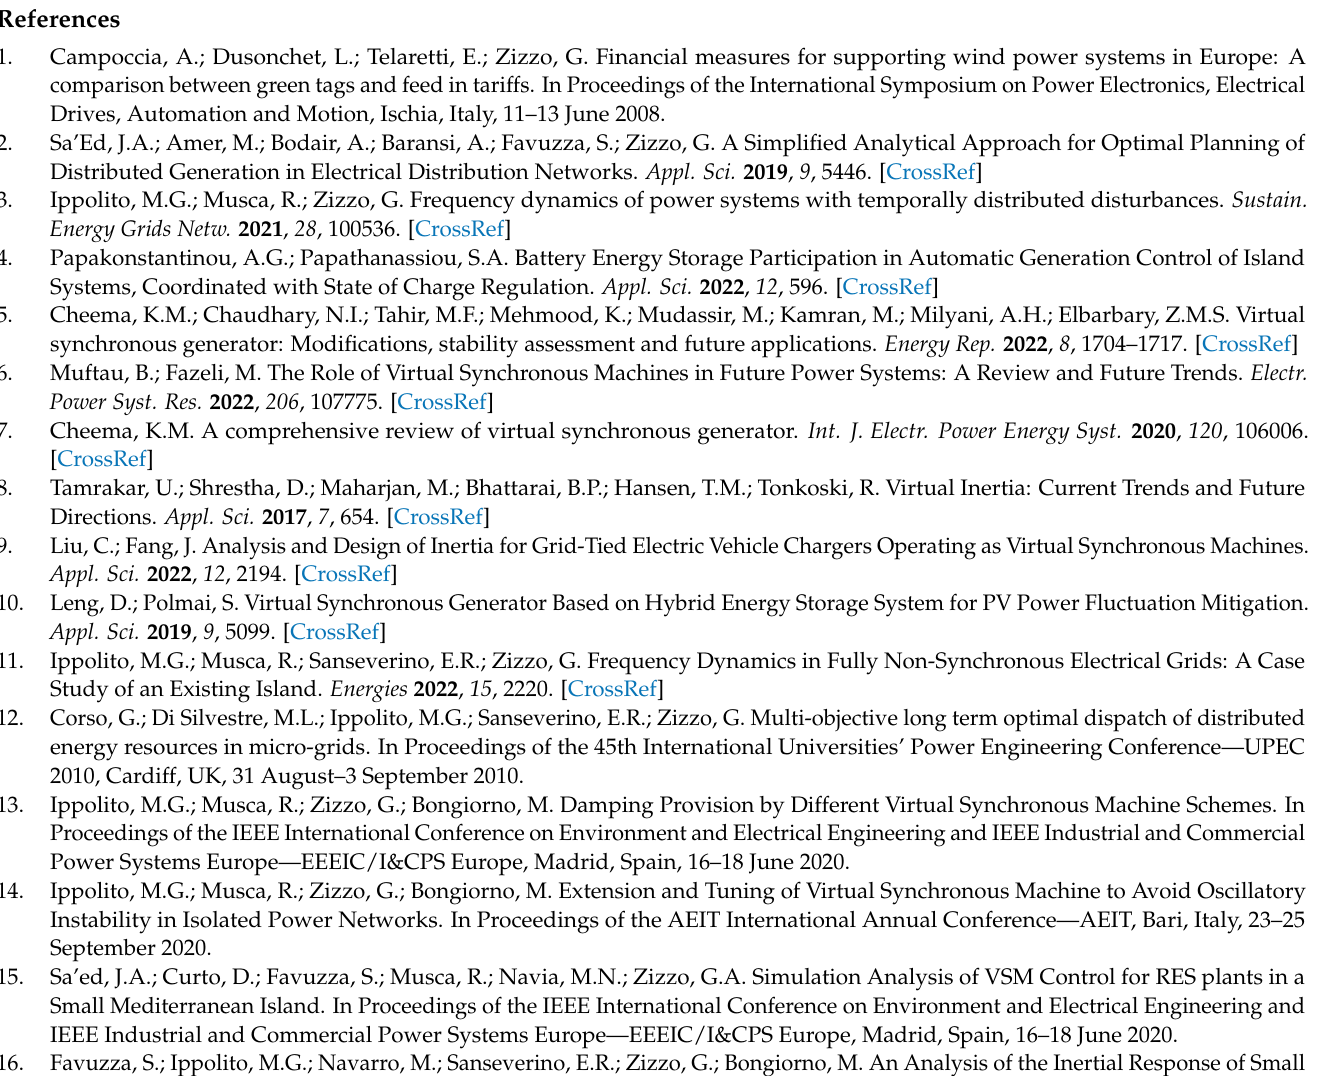
Figure A2. Load and RES active power with SCR = 3.